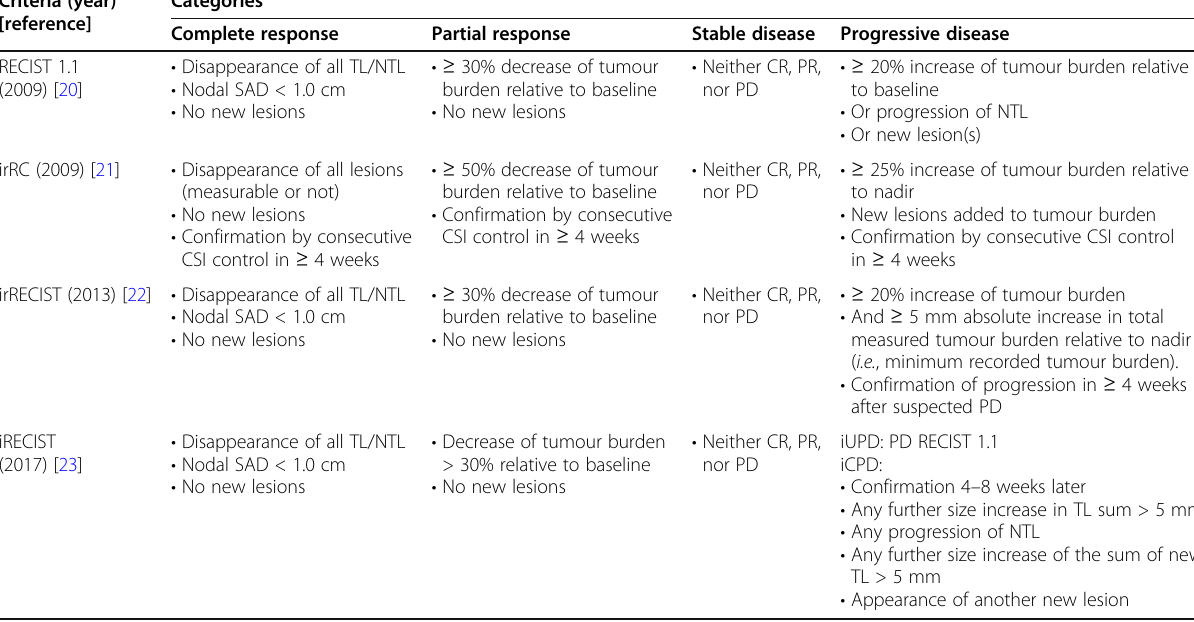
Table 1 Overview of criteria for anatomical response evaluation to immunotherapy Criteria (year)